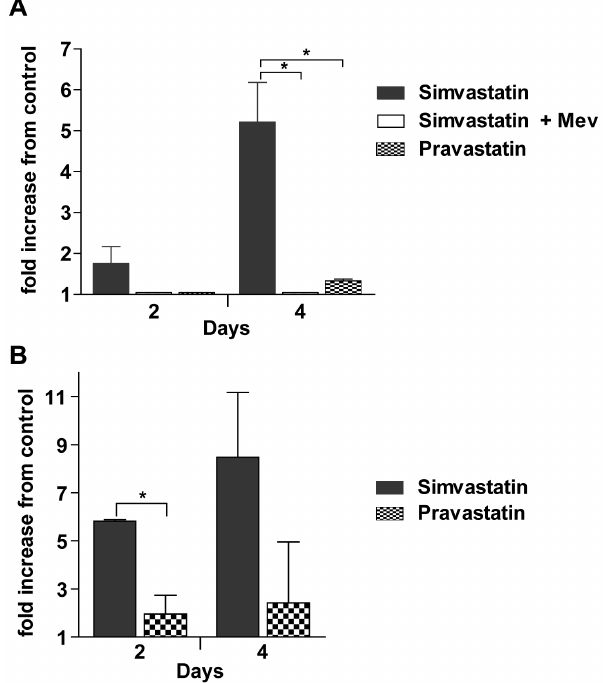
Figure 6. Simvastatin, but not pravastatin, induces apoptosis in somules and adult worms. A . Newly transformed somules were incubated in the presence of either 10 m M simvastatin ( 6 100 m M mevalonate) or pravastatin for the times indicated. Caspase activity was then measured using the fluorescent substrate Z-DEVD-R110 as described in the text and is expressed relative to DMSO controls. Bars represent means 6 S.D. across two independent experiments. Significance (p , 0.05) was measured using Student’s t -test and is indicated with an asterisk. B . As for A, but employing adult worms. Bars represent means 6 S.D. across two independent experiments. Significance (p , 0.05) was measured using Student’s t -test and is indicated with an asterisk.